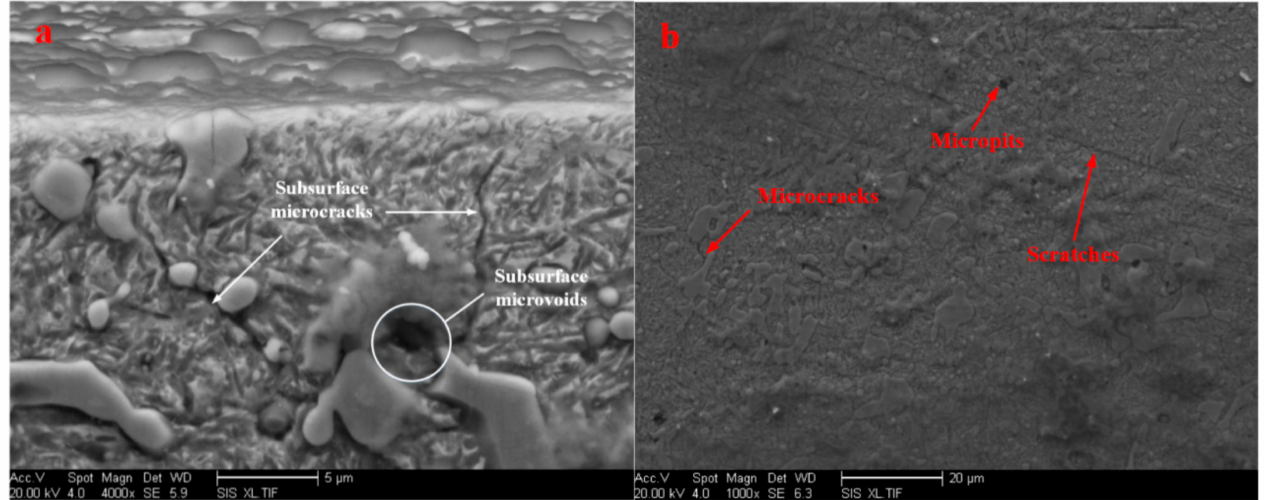
Figure 12. Microstructure of subsurface and machined surface of bionic pit fatigue specimen: ( a ) mi- crostructure of subsurface layer of fatigue specimen; ( b ) microstructure of milled surface of fa- tigue